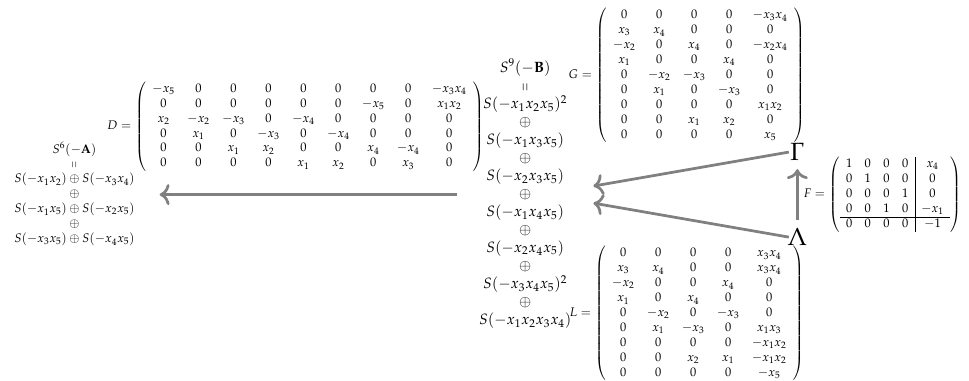
Figure 1. The matrix representation of the first differential d : S 9 ( − B ) → S 6 ( − A ) of a minimal free resolution of the edge ideal of the bowtie graph I G = (cid:104) x 1 x 2 , x 2 x 5 , x 5 x 1 , x 5 x 3 , x 3 x 4 , x 4 x 5 (cid:105) and two possible minimal generating set for its